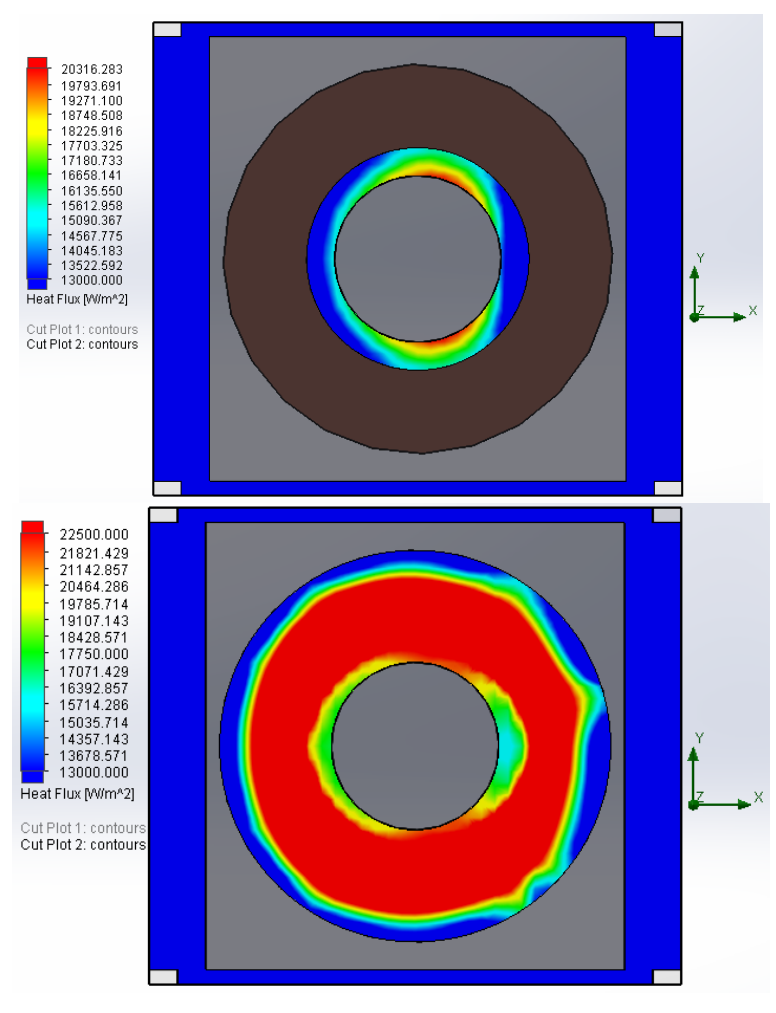
Figure 14. Heat flux tube plot, and heat flux fin zone plot.